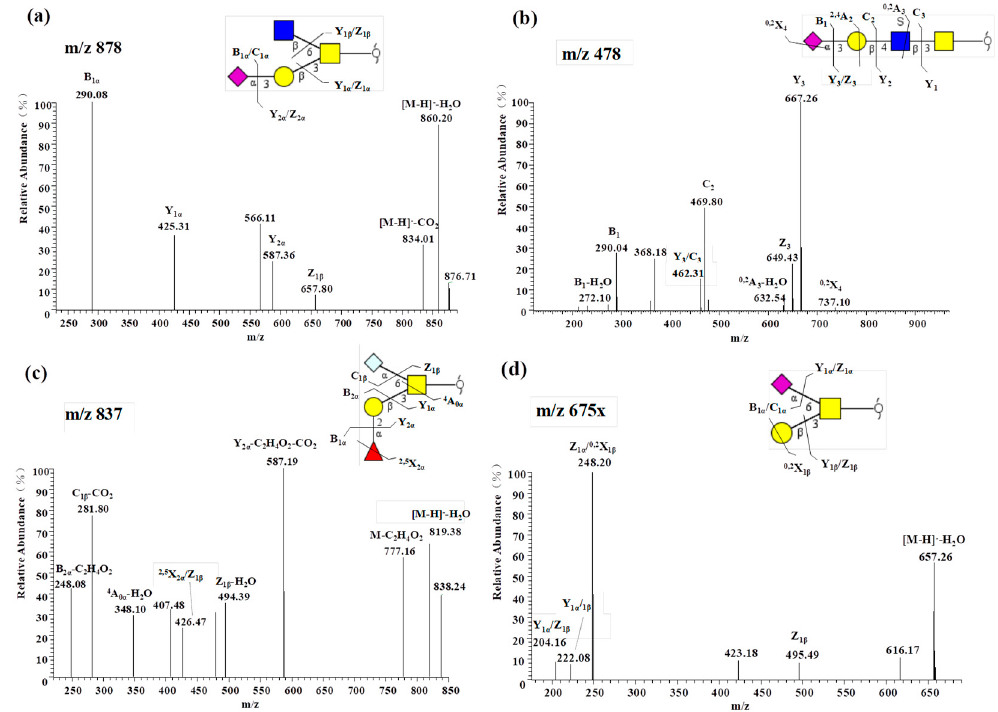
Figure 3. MS / MS spectra of sialylated oligosaccharides recorded in the negative ion mode: ( a ) and ( b ) oligosaccharide with a Neu5Ac α 2-3 linked to a Gal residue; ( c ) oligosaccharide with a Neu5Gc α 2-6 linked to a GalNAc-ol; ( d ) oligosaccharide with a Neu5Ac α 2-6 linked to a GalNAc-ol.